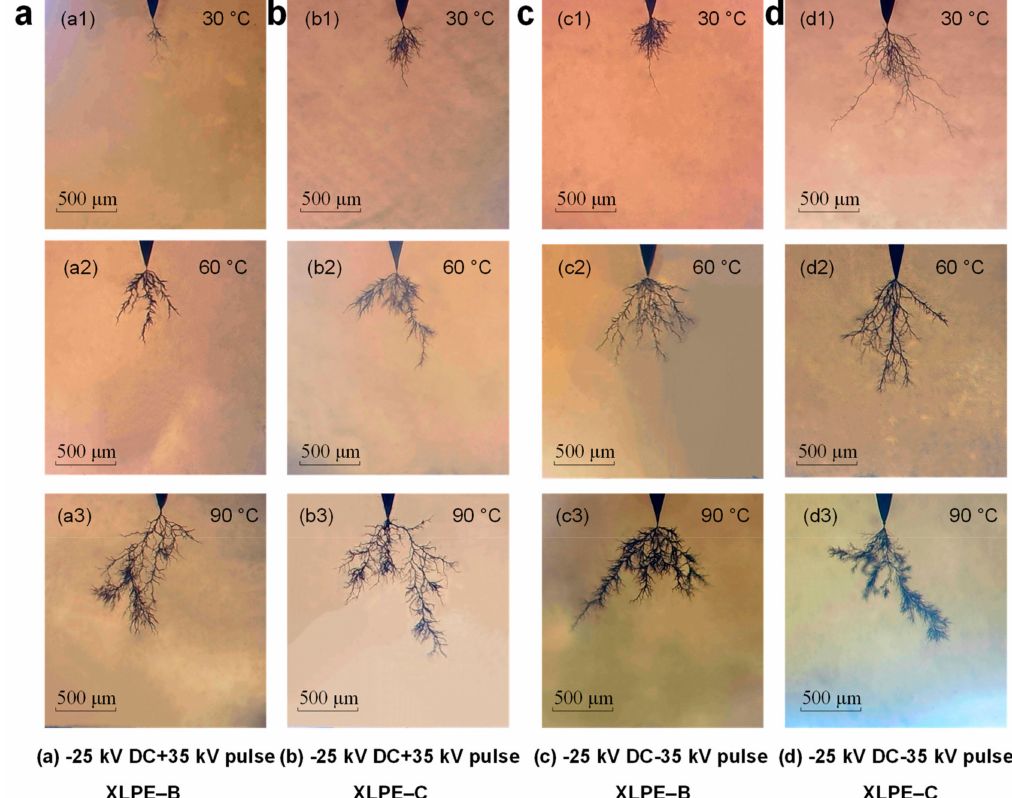
Figure A2. The electrical tree structures of XLPE − B and XLPE − C